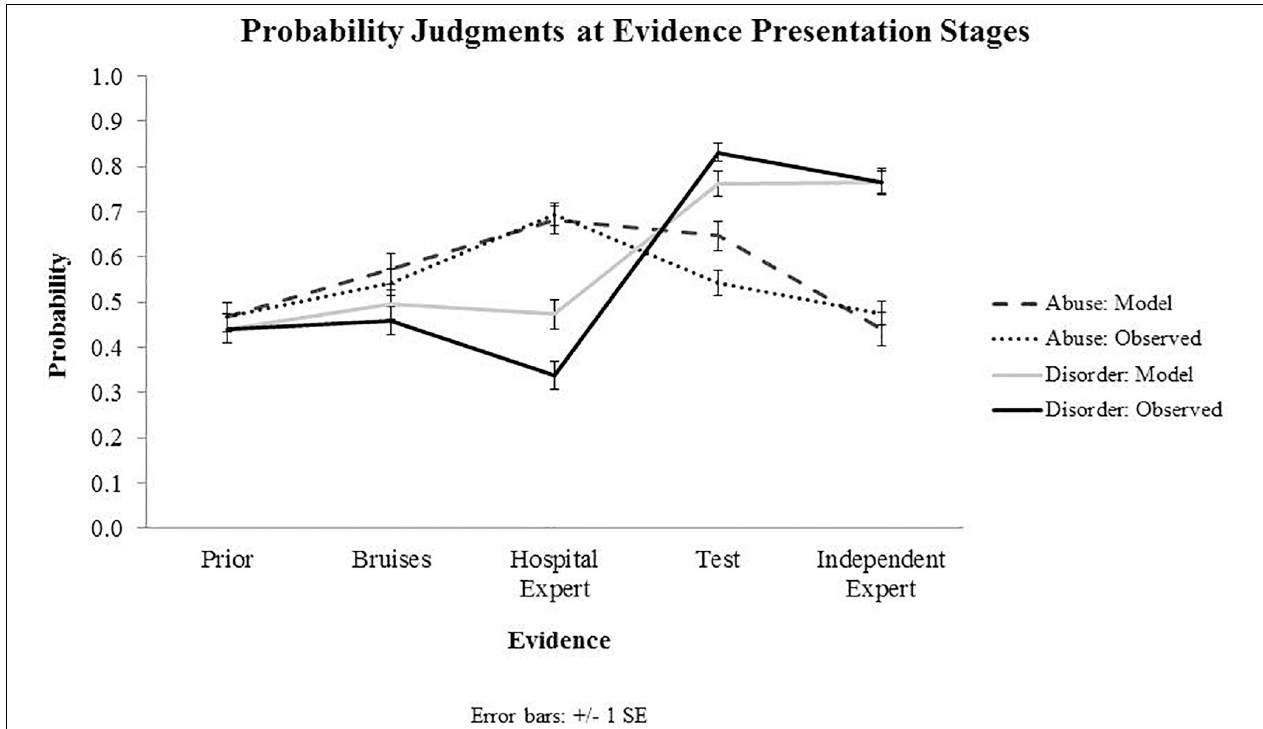
FIGURE 5 | Results from Experiment 2: The graph presents observed and predicted (model) probability judgments for Abuse and Disorder at each sequential stage of evidence presentation. Priors presented on the graph for both observed and predicted values represent subjective priors set by the